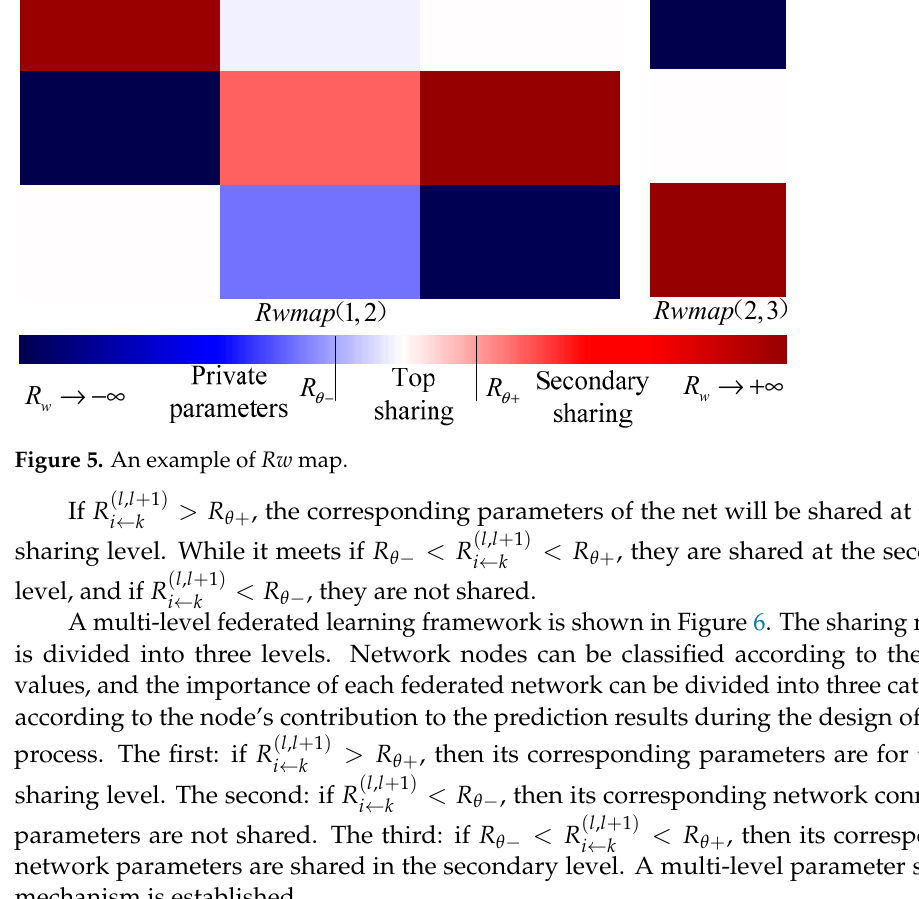
Figure 5. An example of Rw map.